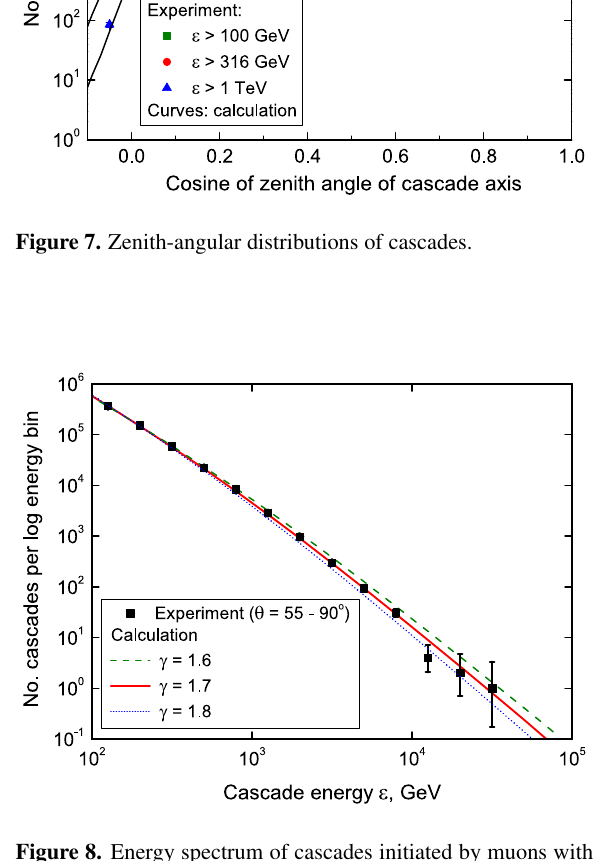
Figure 8. Energy spectrum of cascades initiated by muons with zenith angles exceeding 55 ◦